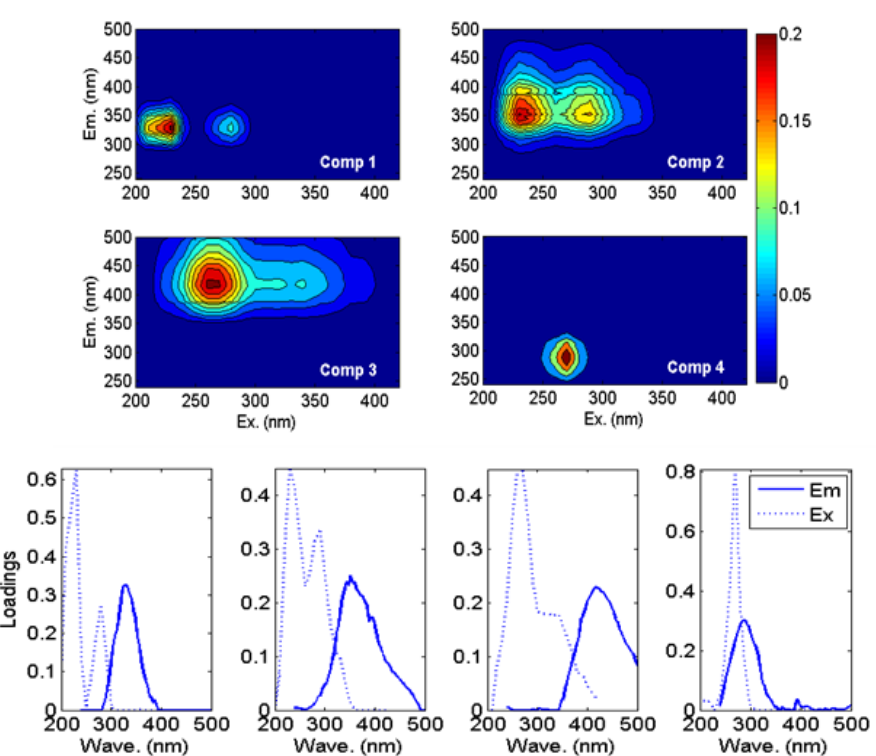
Figure 6. Excitation-emission matrices (EEMs), excitation, and emission spectrum loadings of four fluorescence components derived from a parallel factor (PARAFAC) model of geothermal water from depths greater than 1200 m.